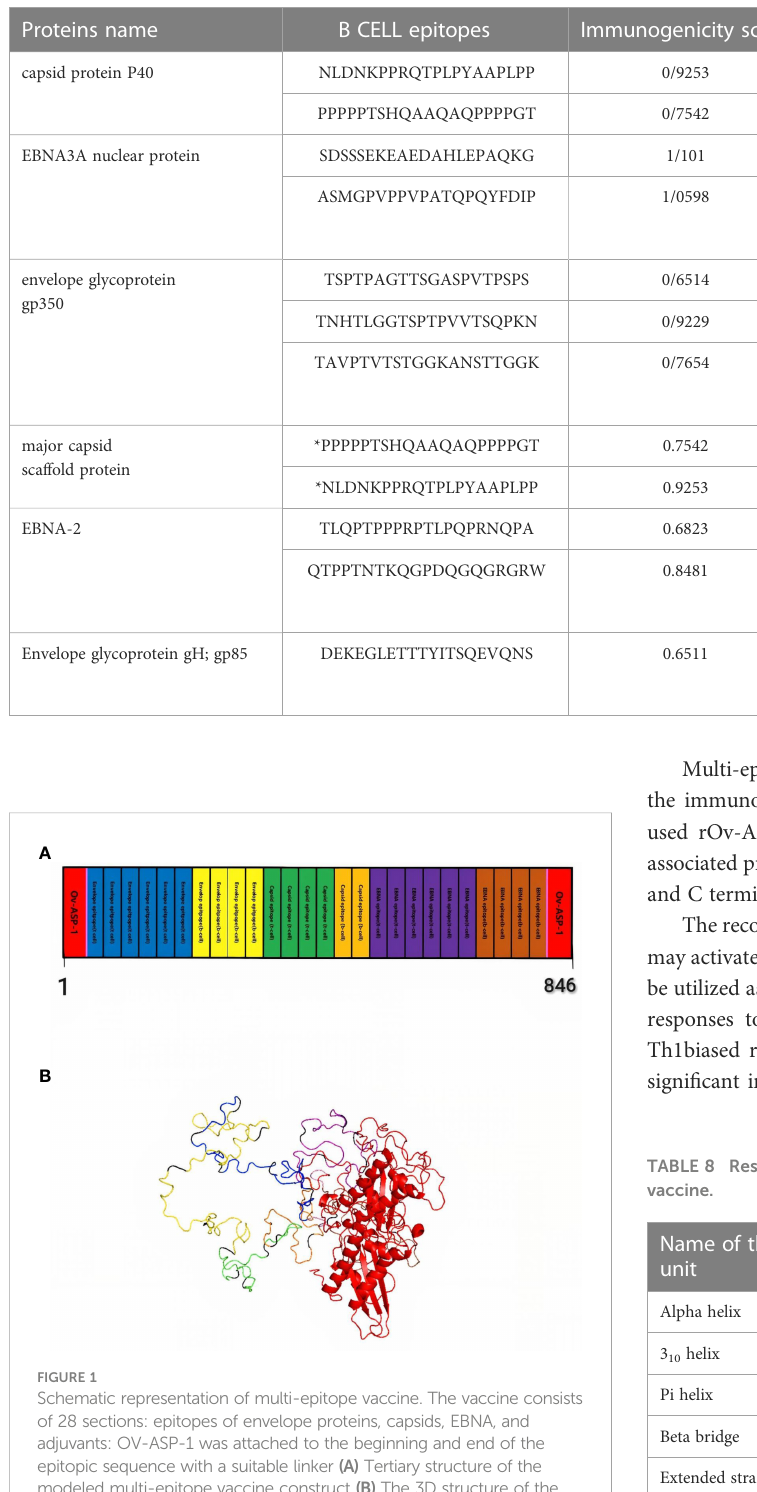
TABLE 7 selected Epitopes for the vaccine.